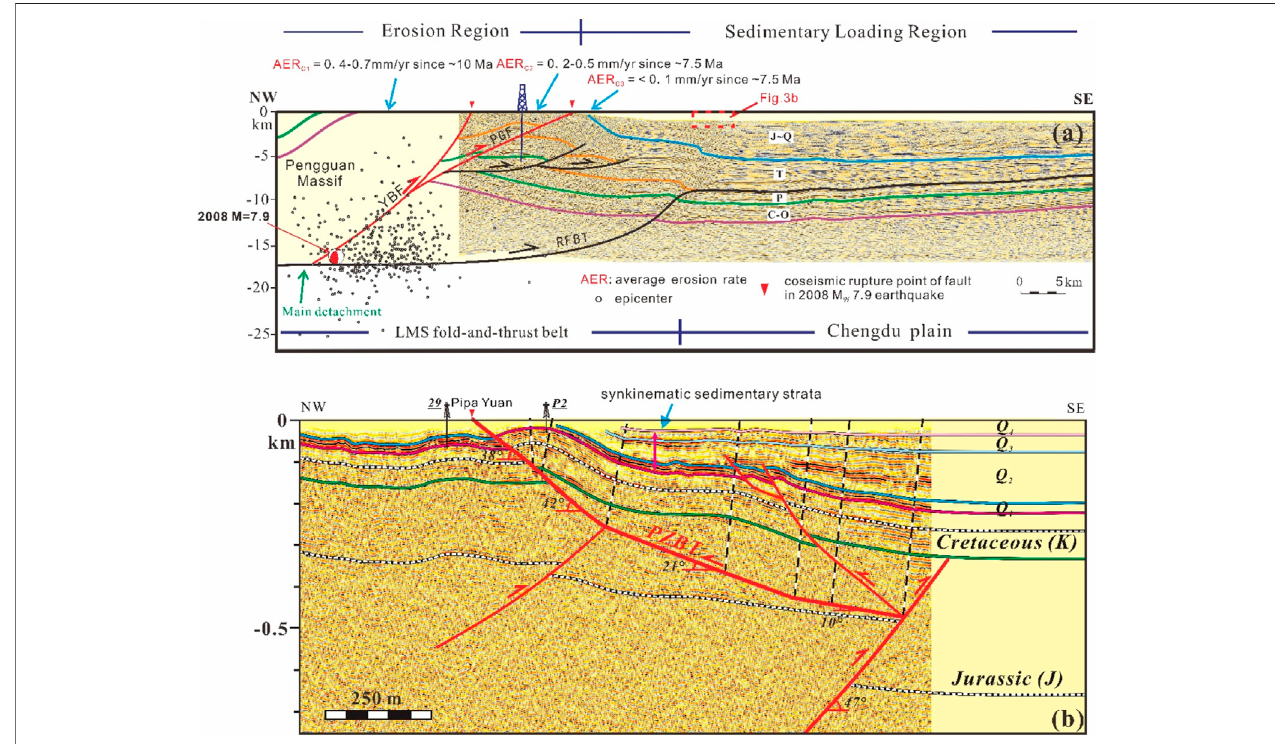
FIGURE 3 | (A) the structural interpretation of the central LMS fold-thrust belt (modi fi ed from Jia et al., 2010, Li et al., 2010 and Li et al., 2018b, see the location in Figure 1 ; data of average erosion rate (AER) reference from Tan et al., 2017). The measured coseismic slip of the surface rupture (Xu et al., 2009) indicates that the displacement in the central segment is dominated by thrust slip. (B) Interpretation of the shallow seismic pro fi le that exhibits the presence of the synkinematic strata. These pro fi les also show that there are typical characteristics of regional erosion and sedimentary loading in the central LMS fold-thrust belt.